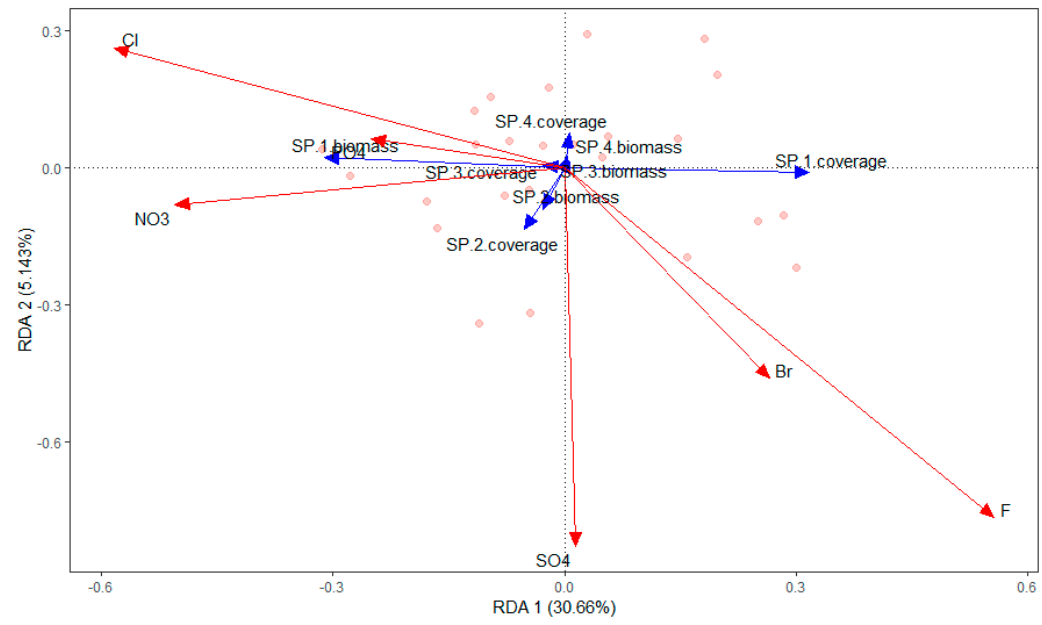
Figure 6. RDA ordination diagram of the relationship between aquatic species and anions in Chenghai Lake.